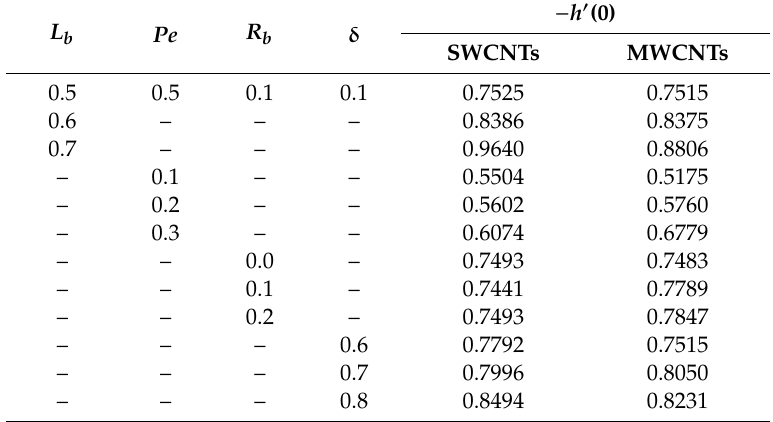
Table 6. Values of Motile density number − h (cid:48) ( 0 ) versus various estimates of di ff erent